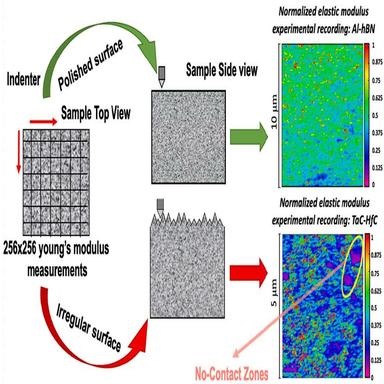
Schematic representation showing nanoindenter during modulus mapping characterization for heterogeneous materials with smooth surfaces resulting in a well-depicted modulus map (Top) and irregular surfaces resulting in a modulus map with anomalous measurements (Bottom).